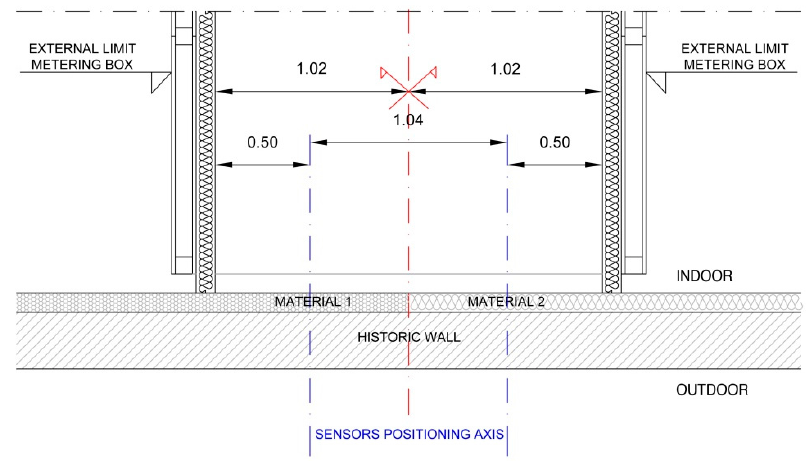
Figure 4. Metering hot box positioning (plan). Relation between the box and sensor location if two insulation materials are tested.